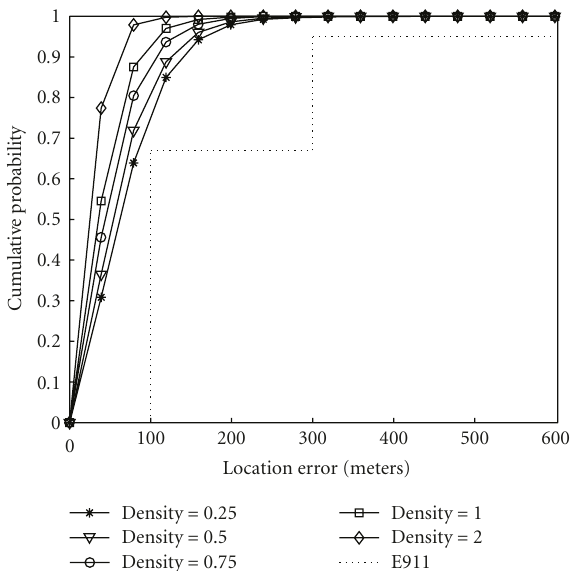
Figure 10: REWL location error CDF by node density for 2.4GHz.